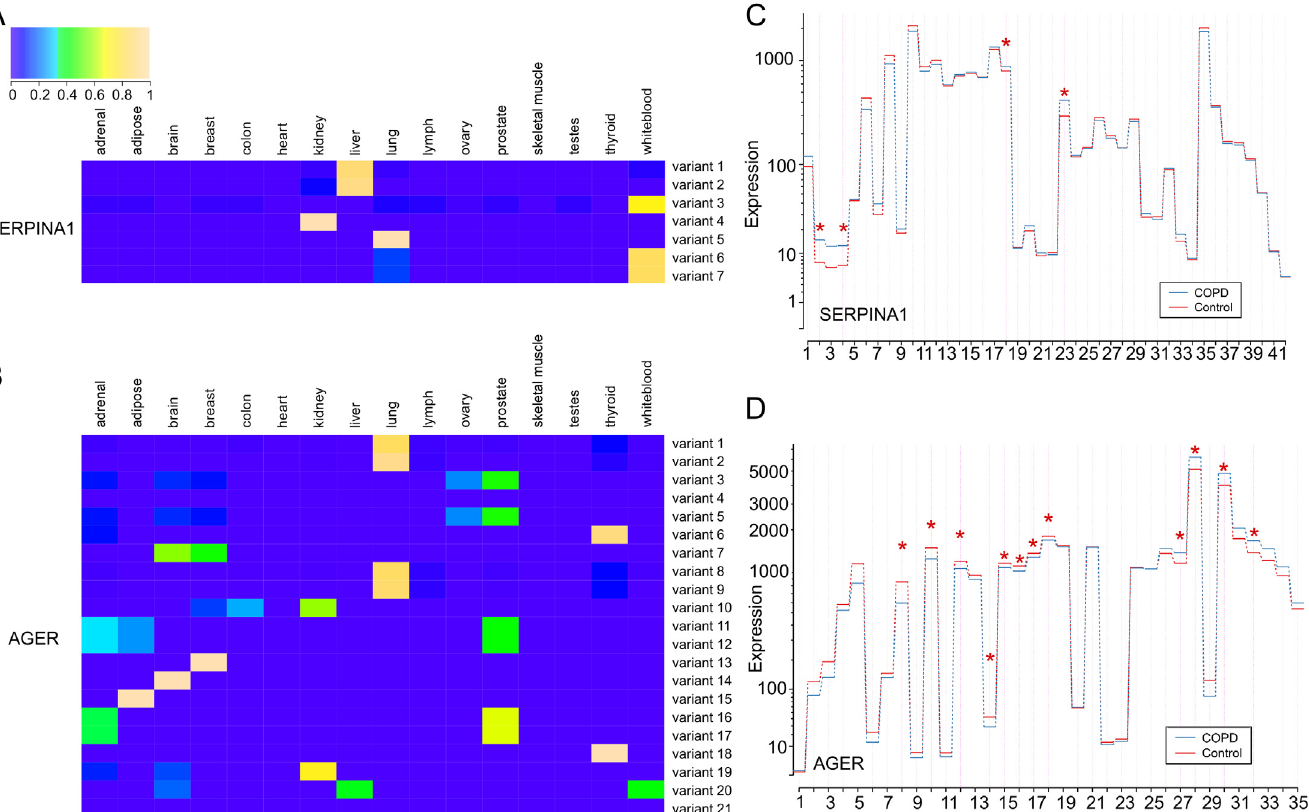
Fig 7. Usage of SERPINA1 and AGER splice variants by tissue and COPD status. (A) The expression of each splice variant in SERPINA1 was normalized across tissues. The pattern of expression shows that these splice variants are not broadly used in every tissue, but specific to the kidney, liver, lung and white blood cells. (B) Likewise, AGER is expressed in nearly every tissue tested, but splice variants are have specific patterns that imply regulation. Splice variants were determined as alternative splice sites through ASprofile [95]. (C) RNA-seq data from control subjects and COPD patients indicate that in SERPINA1 four exons are significantly differentially used (p < 0.05). (D) In the AGER gene twelve exons are differentially expressed in COPD patients compared to normal controls (p < 0.05). Exon usage was generated with DEXSeq